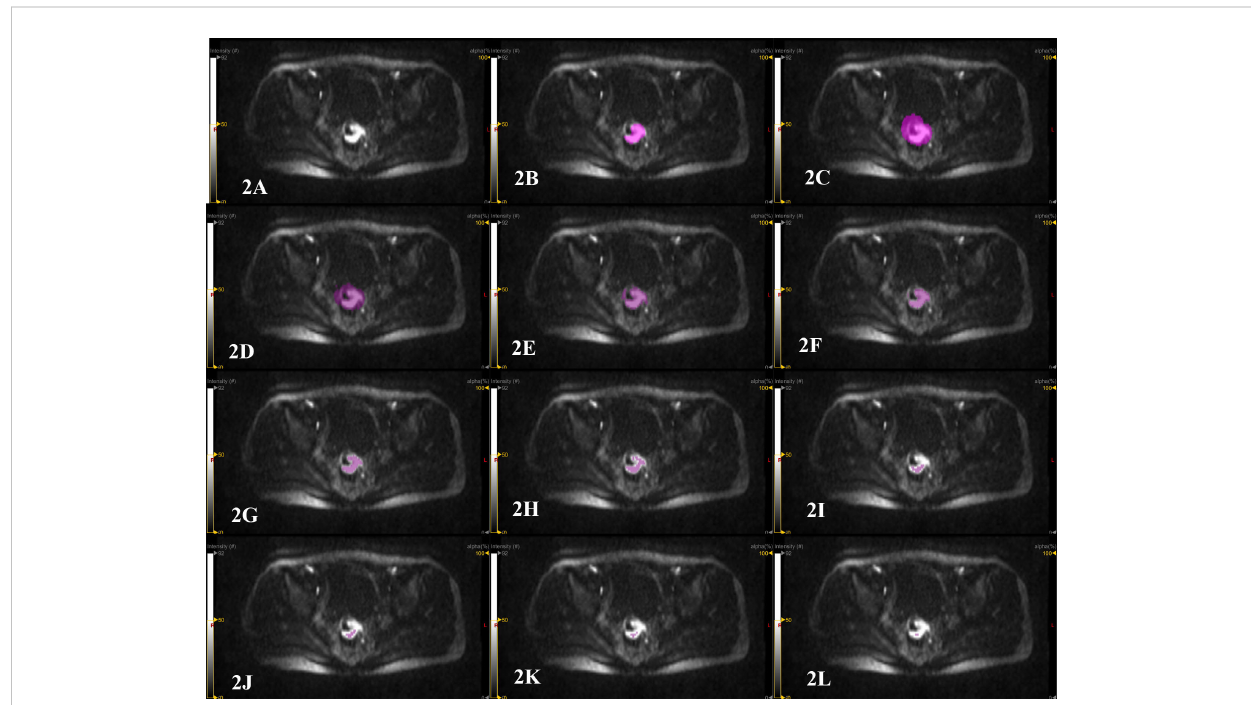
FIGURE 2 Patient, male, 67 years old, with distal rectal cancer. (A) the original image of the primary rectal cancer on a certain layer of the DWI image with b=1500 s/mm 2 . The high signal area is the tumor area. (B) manual delineation of the primary lesion of rectal cancer on this layer using the pencil 2D tool in the LIFEx software to measure GTV. The LIFEx software shows that the volume of the rectal tumor on this level is 4.078 cm 3 . After the lesion is delineated layer by layer, the LIFEx software automatically integrated the tumor volume of each layer, and the GTV was 22.25 cm 3 . (C) semi- automatic delineation of the primary lesion of rectal cancer by using the circle 3D tool of LIFEx software to cover the entire area of the primary rectal cancer. (D – L) semi-automatic delineation of tumor lesions using 10%, 20%, 30%, 40%, 50%, 60%, 70%, 80% and 90% of the highest signal intensity in the area as thresholds. The measured GTV were 70.29 cm 3 , 34.52 cm 3 , 19.16 cm 3 , 10.52 cm 3 , 5.564 cm 3 , 1.813 cm 3 , 0.705 cm 3 , 0.252 cm 3 and 0.101 cm 3 .